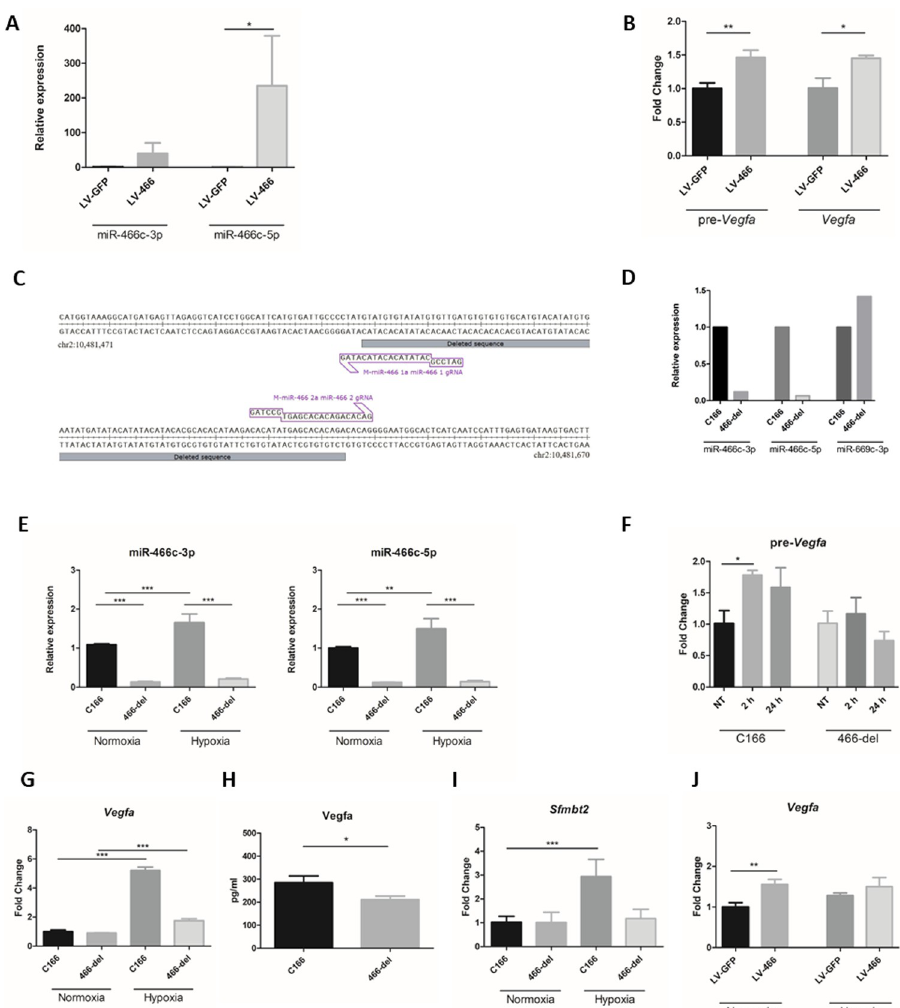
Fig 2. miR-466c participates in the regulation of Vegfa expression. A. Lentiviral expression of miR-466c increased both miR-466c-3p and miR-466c-5p levels in C166 cells. Cells were transduced with MOI 10 and samples collected 3d after transduction. C166 cells transduced with lentiviral vector expressing GFP only (LV-GFP) were used as control. n = 3, ANOVA with Bonferroni correction was used for determining the statistical significance, data is represented as mean ± SD. B. Overexpression of miR-466c (LV-466) in C166 cells resulted in increased transcription of pre- Vegfa and mature Vegfa as compared to control GFP only vector (LV-GFP), using RT-qPCR. n = 3, t-test was used